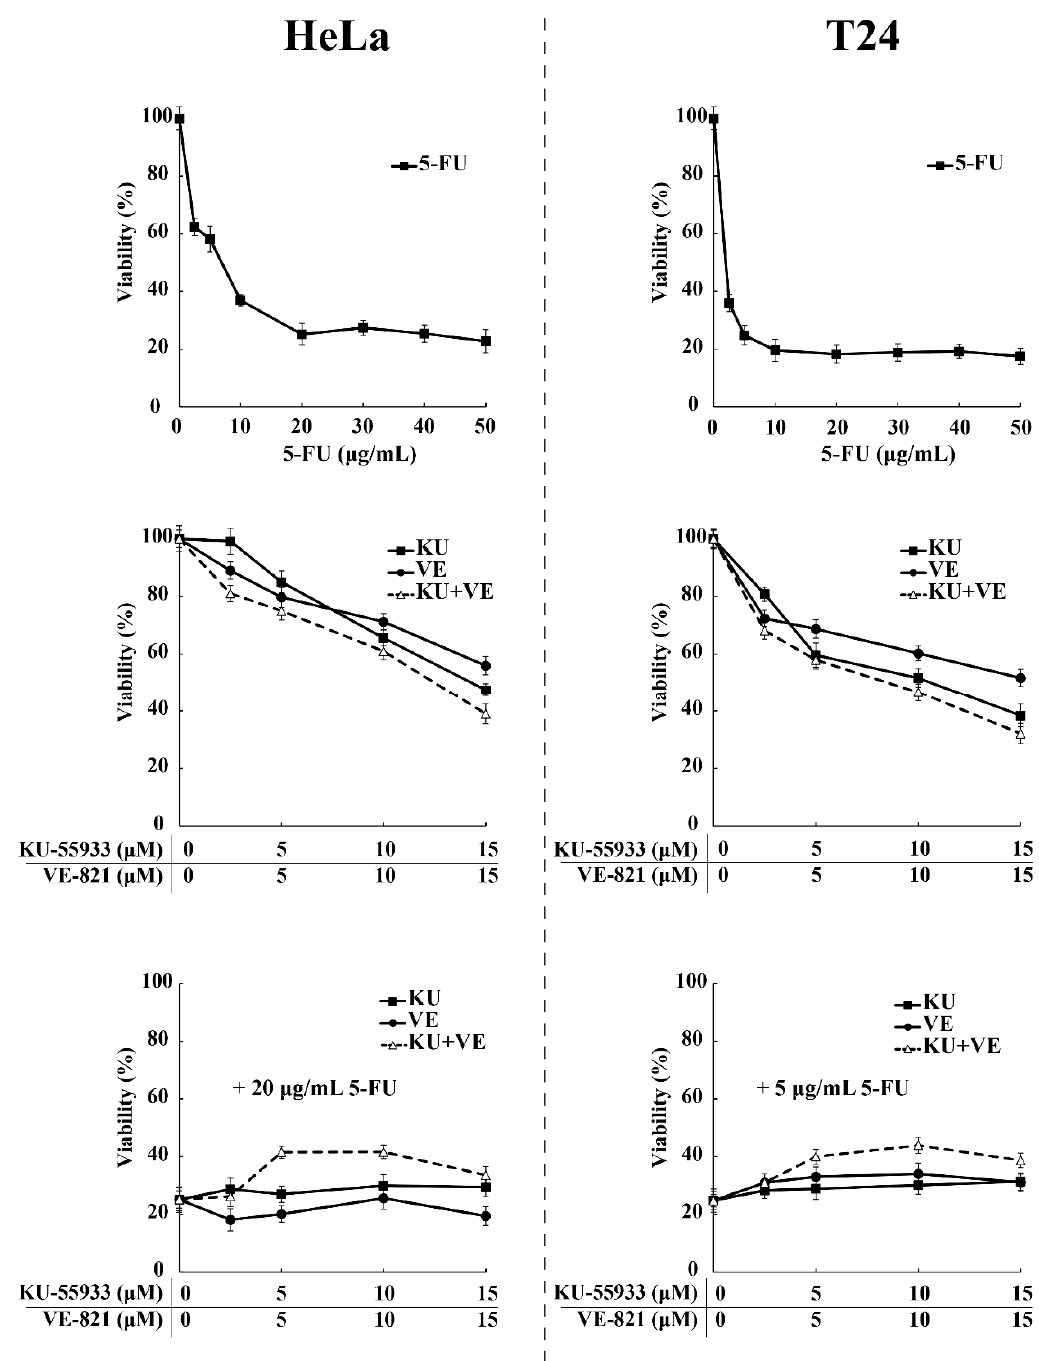
Figure 10. ATR/ATM inhibition protects HeLa and T24 cells from the cytotoxic effects of 5-FU. HeLa ( left panel ) and T24 cells ( right panel ) were treated for 48 h with increasing concentrations of 5-FU and ATR/ATM inhibitors, either alone or in combination, as indicated. The number of viable cells was measured using an MTT assay. Viability is expressed as a percentage of the viability of untreated cells, which was set to 100 percent.